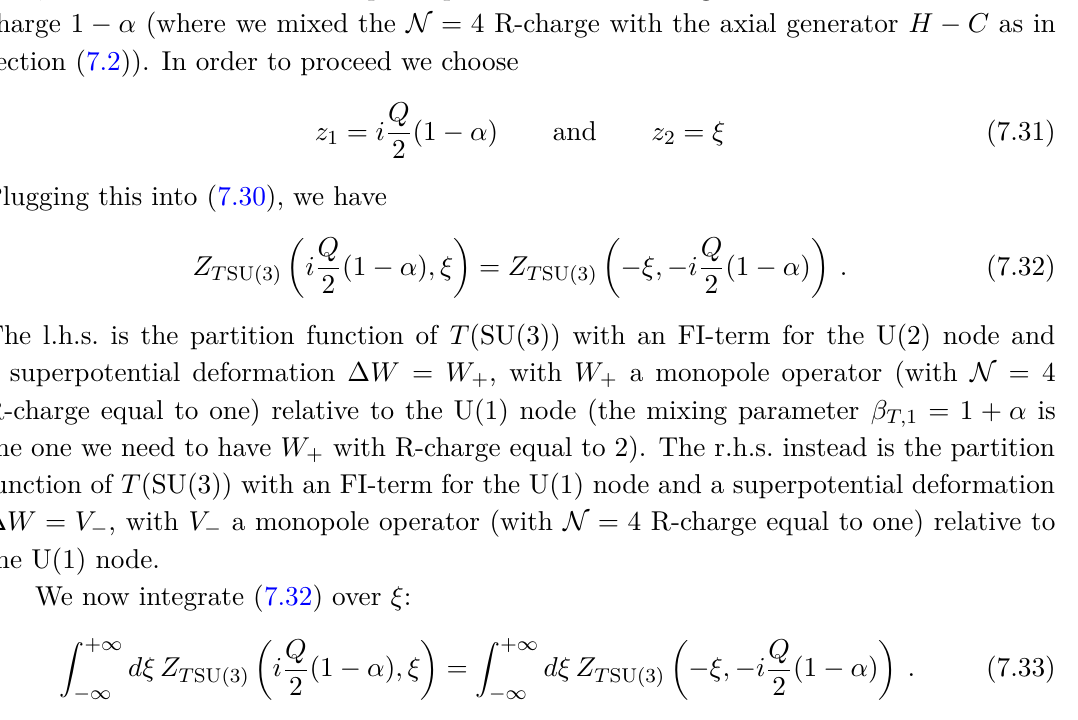
, m , m (subject to constraint m 1 2 3